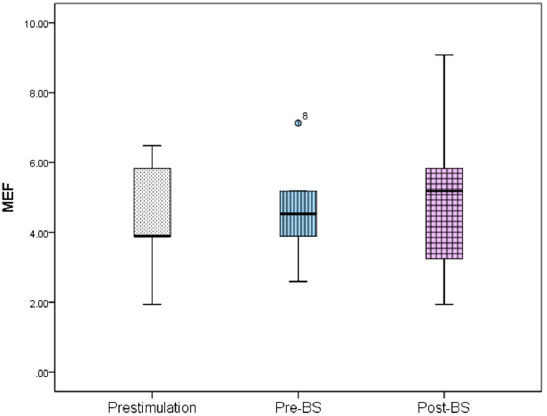
Figure 6. Median frequency (MEF) variation for the prestimulation, pre-BS, and post-BS periods. Error bars represent standard deviation. One-way ANOVA analysis revealed no statistical significance between these periods ( p > 0.05). BS—burst suppression.